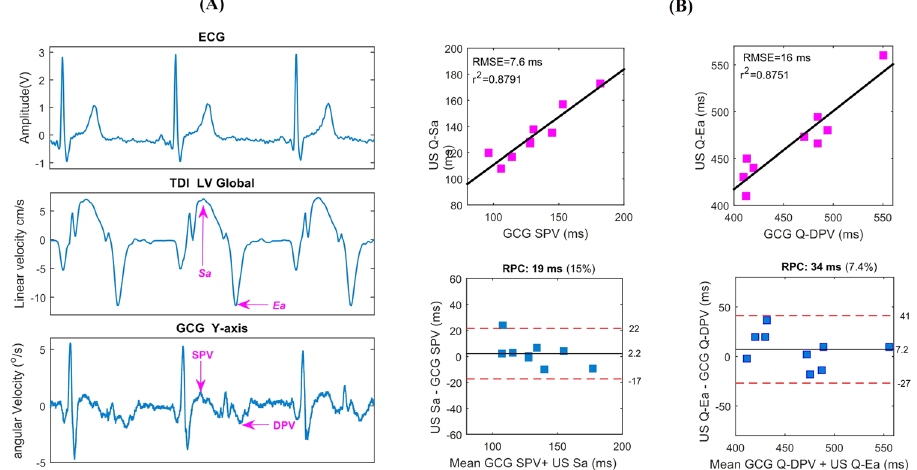
Figure 5. Sa and Ea wave evaluations with TDI and GCG. Qualitative comparison between the TDI Sa and Ea waves and corresponding SPV and DPV in typical GCG y- and z-axis waves ( A ). Quantitative evaluation of time intervals between Q- Sa / Ea versus Q- SPV / DPV waves ( B